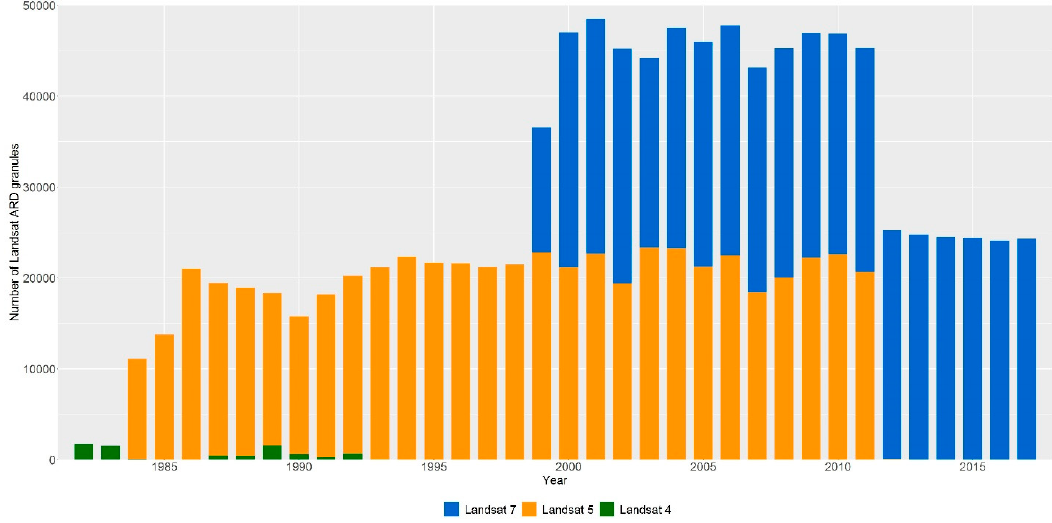
Figure 2. Annual number of Landsat ARD granules over the CONUS for each sensor over the 36-year study period (1 January 1982 to 31 December 2017). The sensor count data (colored bars) are shown stacked on top of each other in periods with overlapping sensor data.